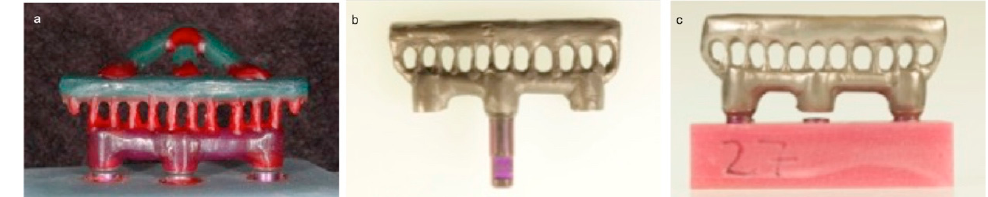
Figure 2. Fabrication of metal frameworks. ( a ) Wax modelling of a framework; ( b ) simulation of single crowns (SCs) by placing the framework on only one implant analog; ( c ) simulation of fixed dental prostheses (FDPs) by placing the framework on the lateral implant analogs of one implant model. All abutments were screwed to the implants with a torque wrench (CAMLOG Biotech- nologies AG, Basel, Switzerland) at a torque of 20 Ncm. To compensate for the setting effect, all screws were tightened again after 10 min [27]. Then, the screw-access openings of the abutments were filled with white gutta-percha (Gutta-percha in sticks, Dentsply DeTrey, Konstanz, Germany). While the first and third coping of the framework were used for the FDPs, the coping in the middle of the framework was used for the SCs (Figure